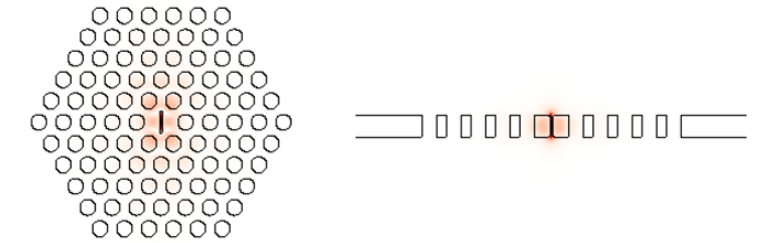
Figure 7. Mode profiles |E| of a slot microcavity in a defect in H1 2D slab photonic crystal. Q is 5.36 × 10 3 , and the mode volume is as small as 0.08( λ /2) 3